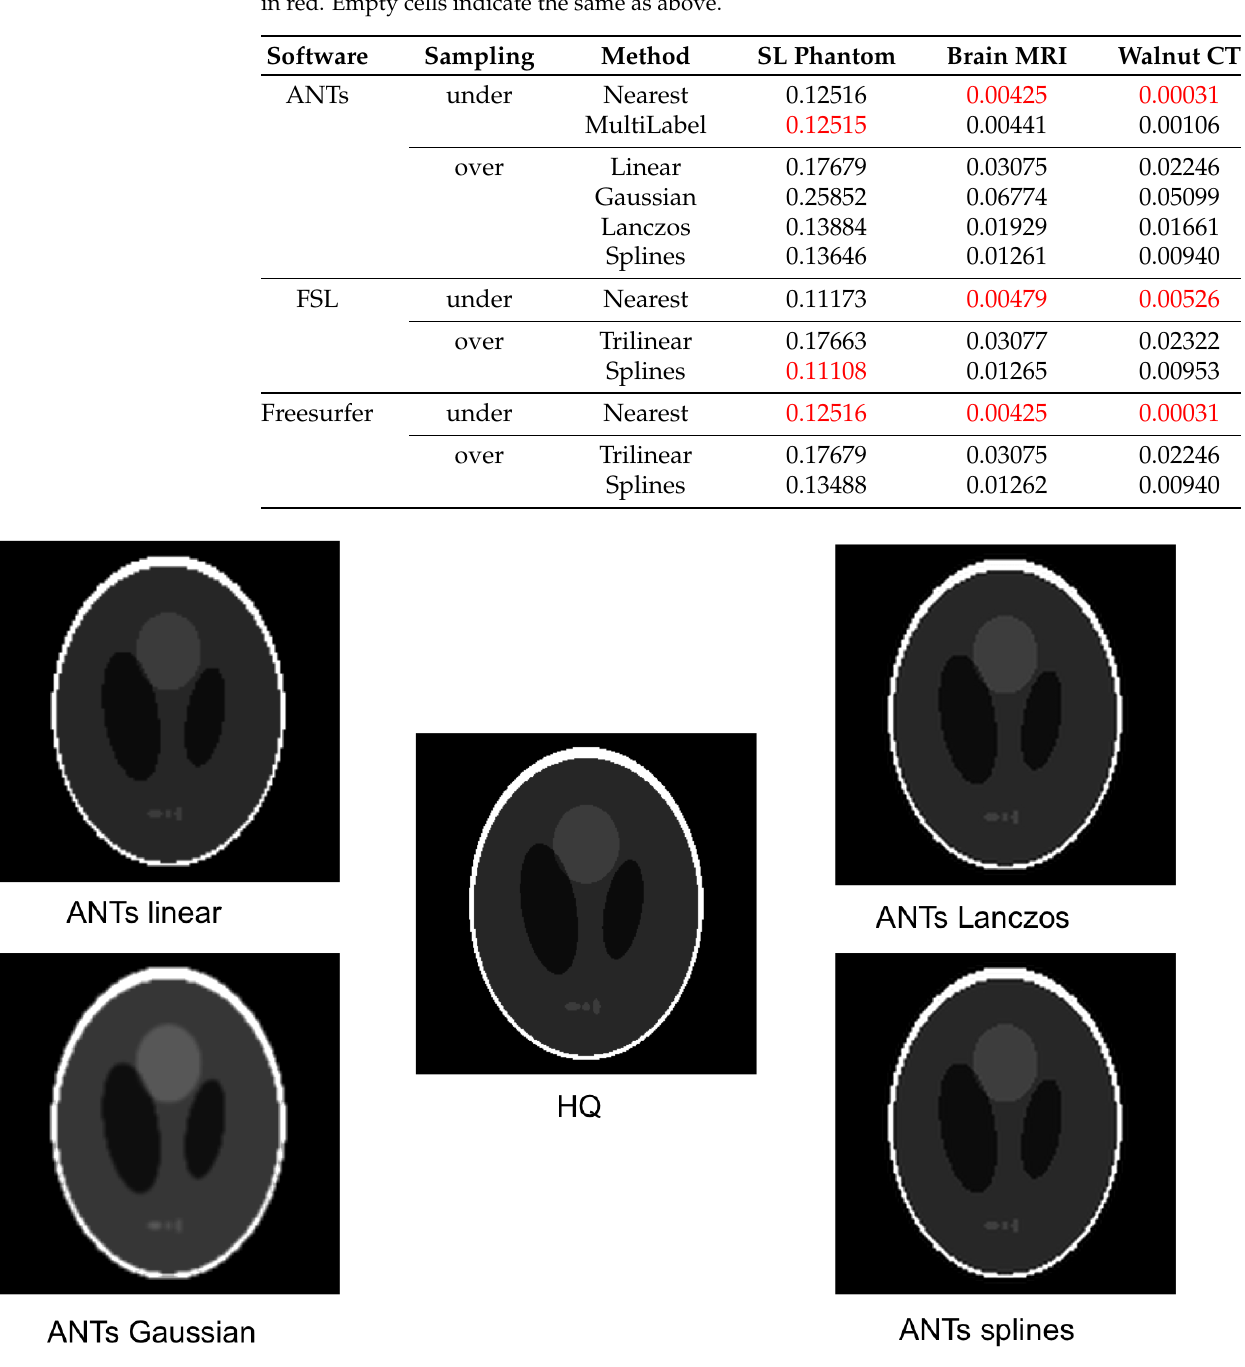
Figure 5. A slice of the Shepp–Logan phantom in High Resolution ( center ), and oversampled in ANTs with four different basis functions (all